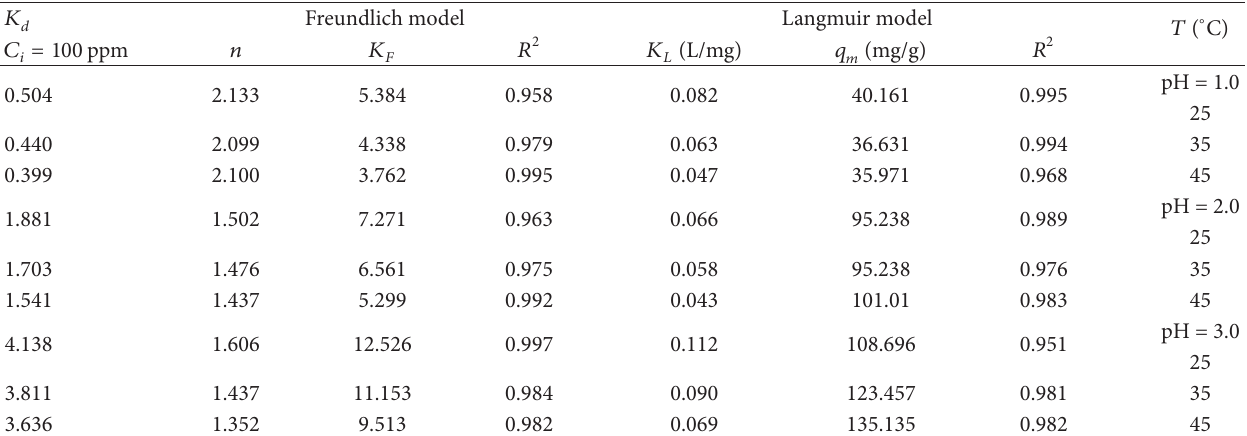
values for the pseudo- �rst- and second-order reaction 𝑞𝑞 𝑒𝑒